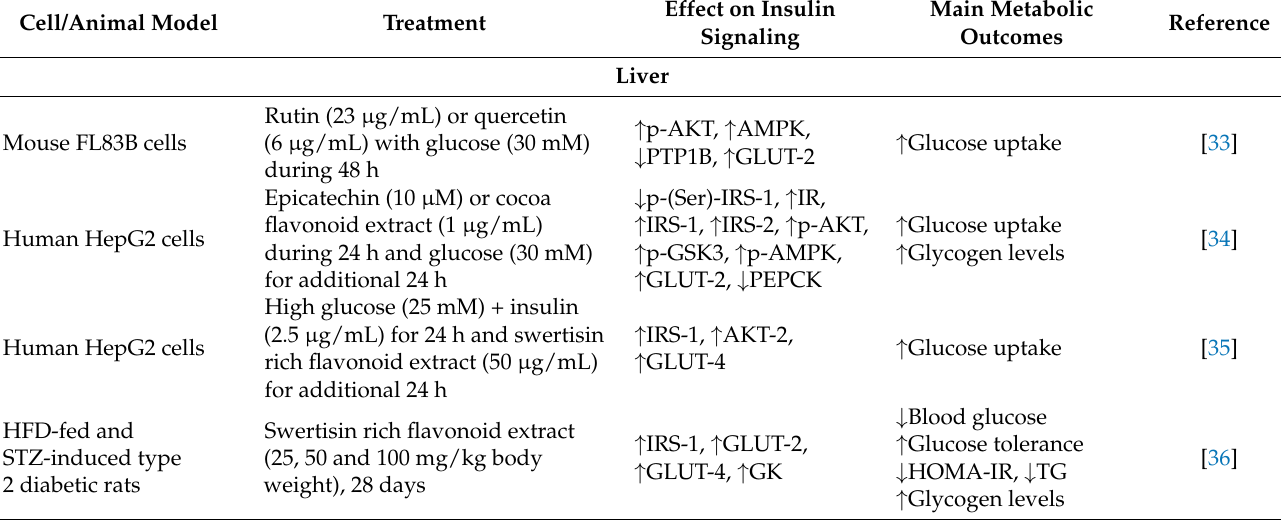
Table 2. Effects of flavonoids on insulin signaling in classical and no-classical target tissues in T2D a . Cell/Animal